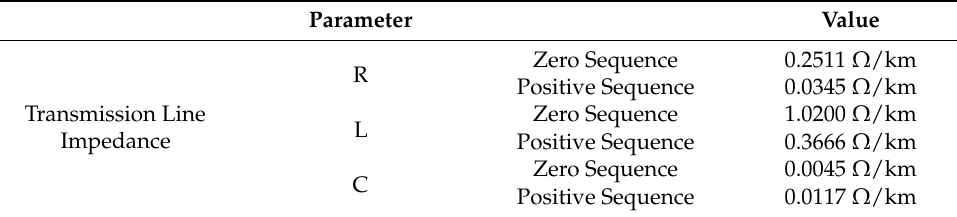
Figure 3. Actual Korean 345 kV transmission study system. Table 1. The 345 kV transmission line parameters.